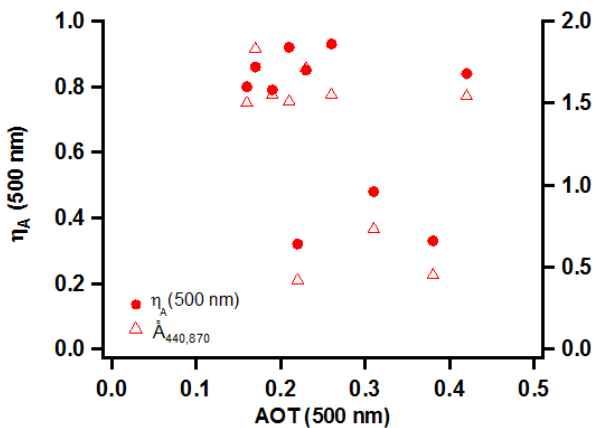
Fig. 14. Scatter plot of η A (500nm) (dots) and å 440 , 870 (triangles) vs. the AOT(500nm) retrieved from AERONET sun photometer measurements collocated in space and time with lidar measure- ments.